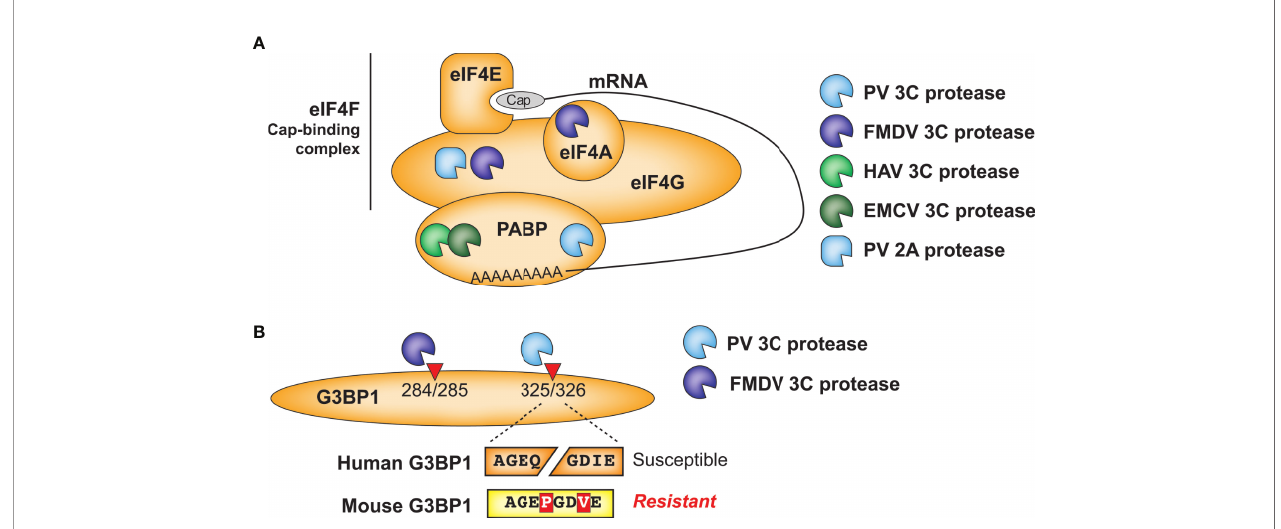
FIGURE 4 | Antagonism of host cellular processes by viral proteases. (A) Diverse viral proteases inhibit translation of host mRNA through cleavage of initiation factors and/or poly(A)-binding protein. (B) Host and virus species-speci fi c cleavage of the stress granule protein G3BP1 by picornavirus